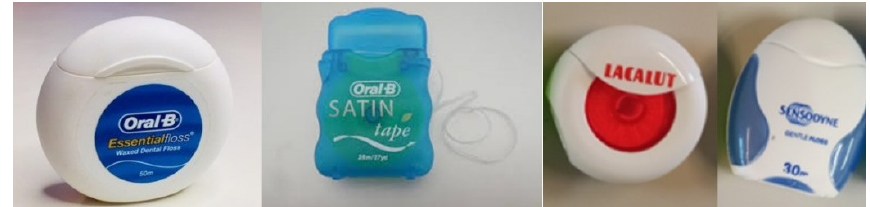
Figure 1. The four utilized flosses of the study in their original containers.